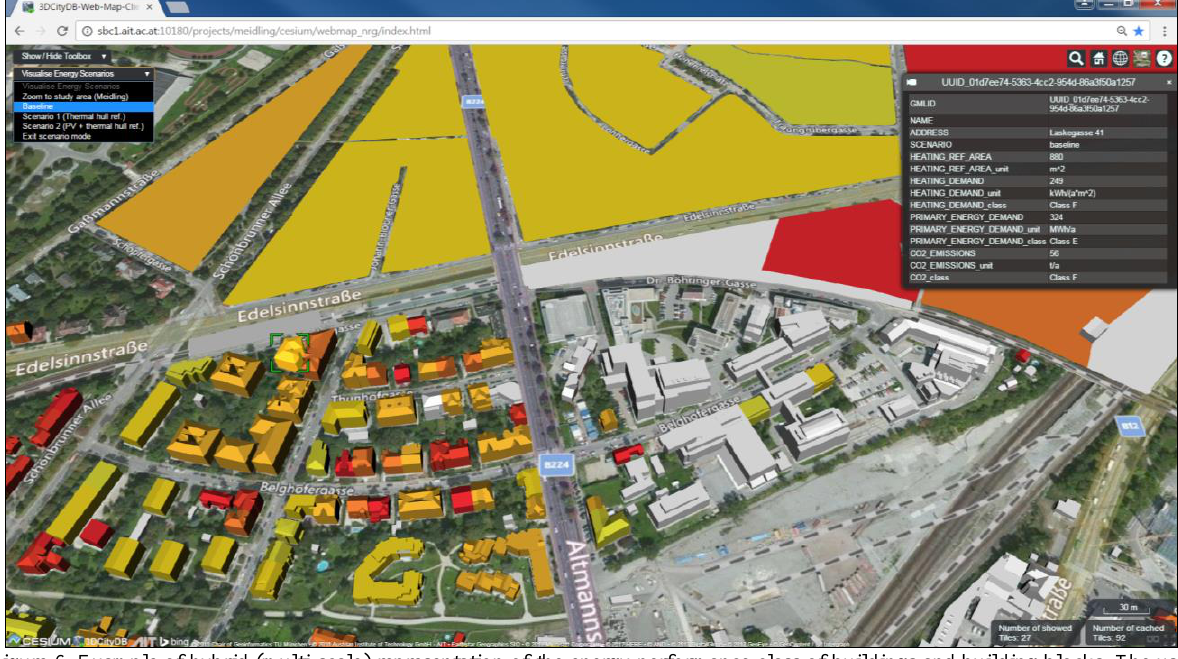
This contribution has been peer-reviewed. The double-blind peer-review was conducted on the basis of the full paper. https://doi.org/10.5194/isprs-annals-IV-4-W3-71-2017 | © Authors 2017. CC BY 4.0